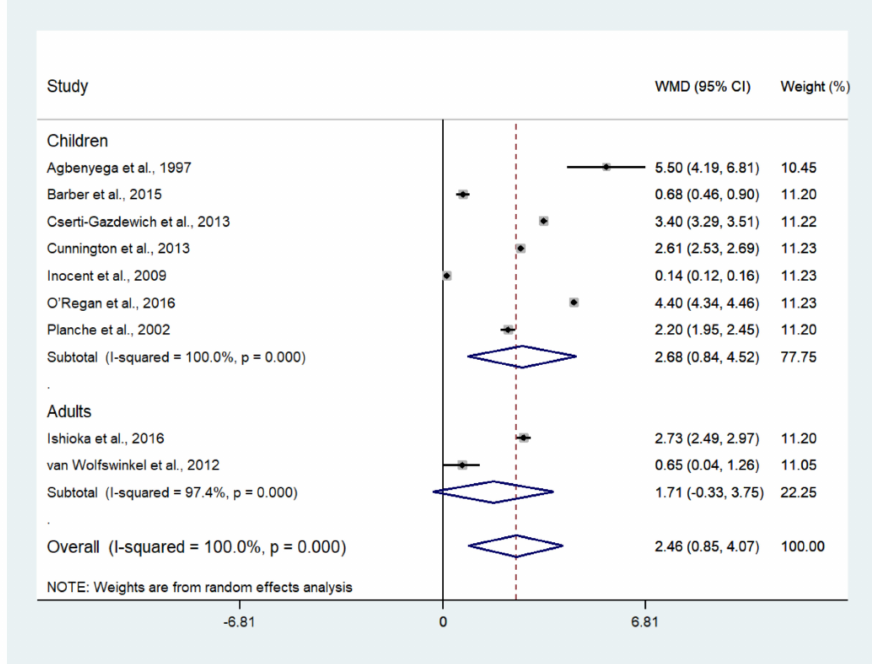
Figure 6. The difference in mean lactate level between patients with severe and uncomplicated malaria. Abbreviations: WMD, weighted mean difference; CI, confidence interval.